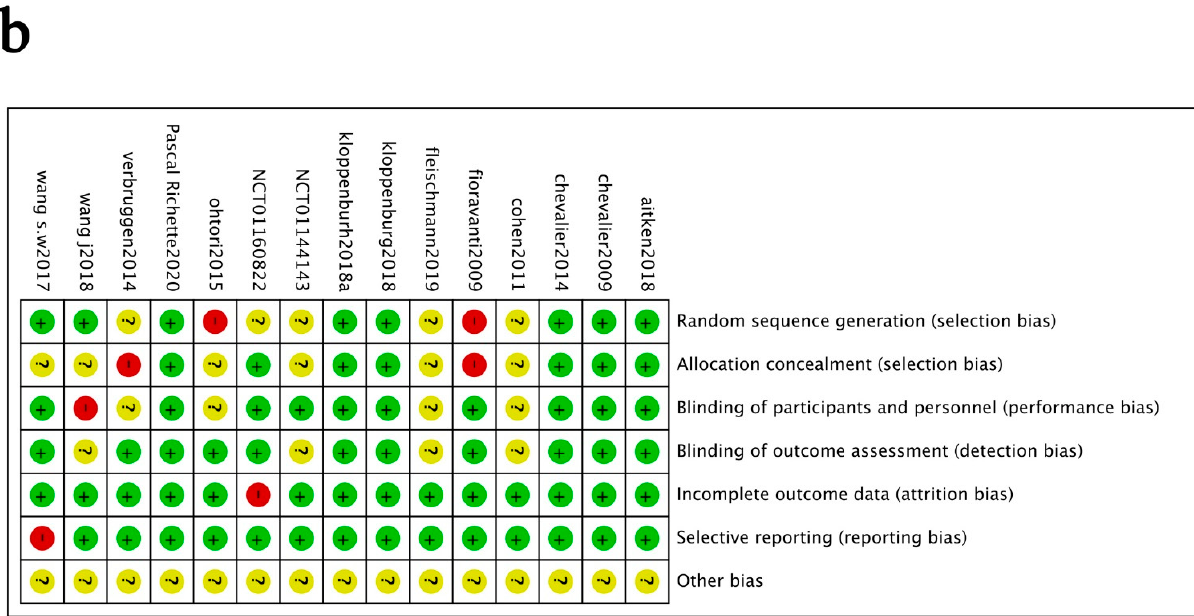
Figure 3. Risk of bias assessment. ( a ) judgements of each bias item presented as percentages across all included studies. ( b ) judgements of each bias item for each included study.